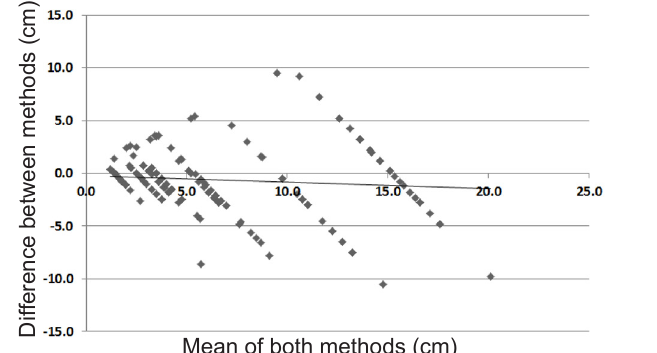
Figure 1. Bland-Altman Plot of data obtained from paired measurements of seven different wound simulations (estimations provided in centimetres). Correlation R = 0.1025 (p-value=0.11).